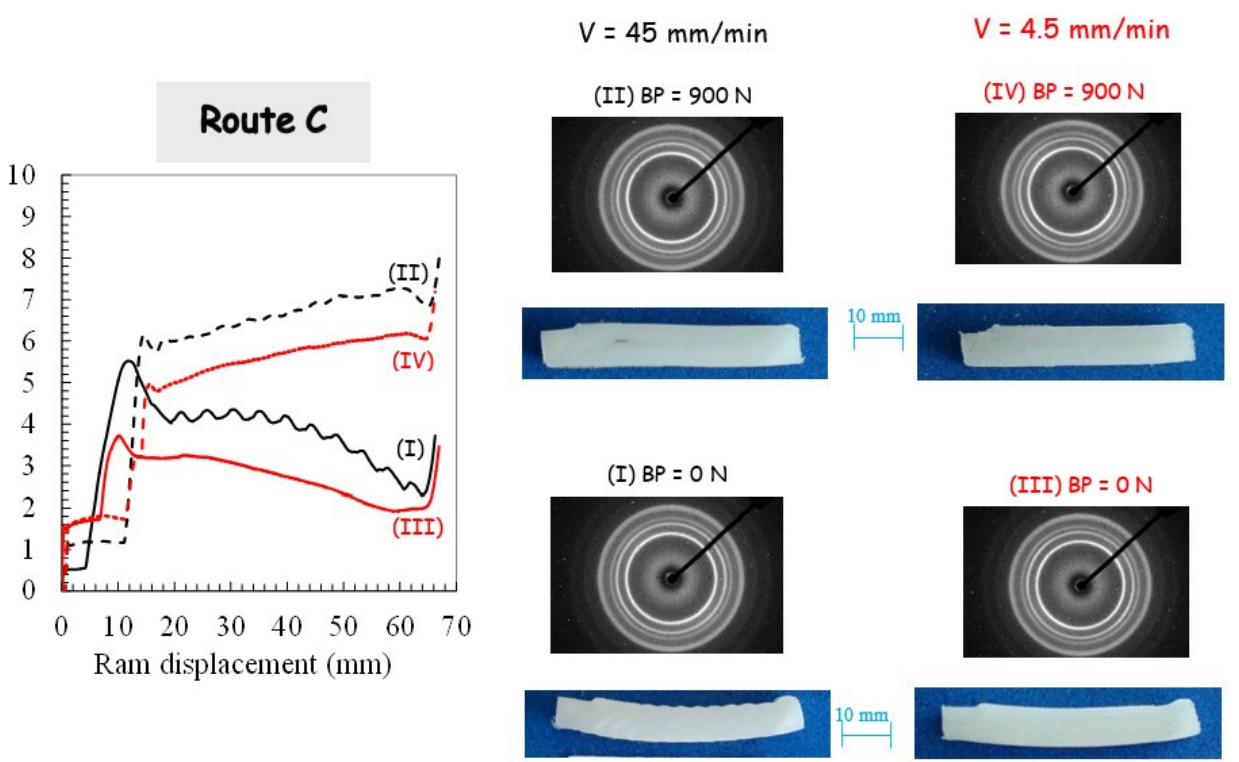
Figure 5. Results of the second pass extrusion in route C in terms of the load-displacement curve, deformation behavior and X-ray diffraction for different processing parameters: ( I ) Ram velocity of 45 mm/min and BP of 0 N, ( II ) Ram velocity of 45 mm/min and BP of 900 N, ( III ) Ram velocity of 4.5 mm/min and BP of 0 N, and ( IV ) Ram velocity of 4.5 mm/min and BP of 900 N.